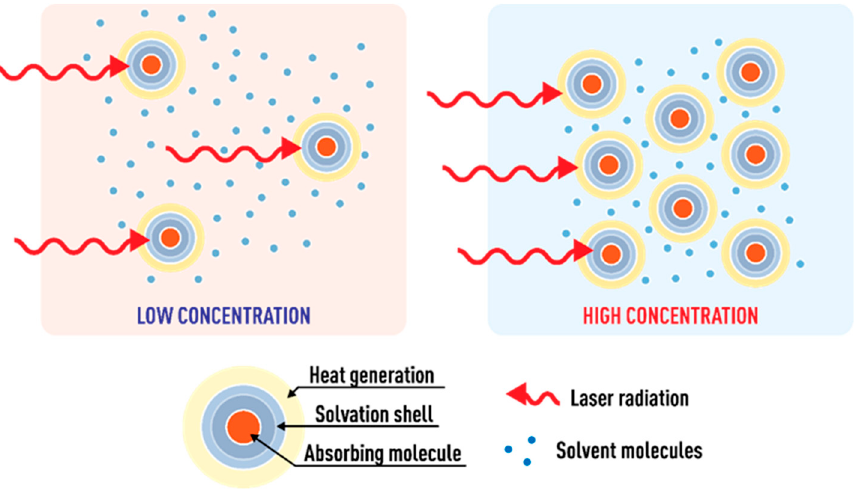
Figure 15. Schematic diagram of heat generation in colorant solutions at low and high concentra- tions.